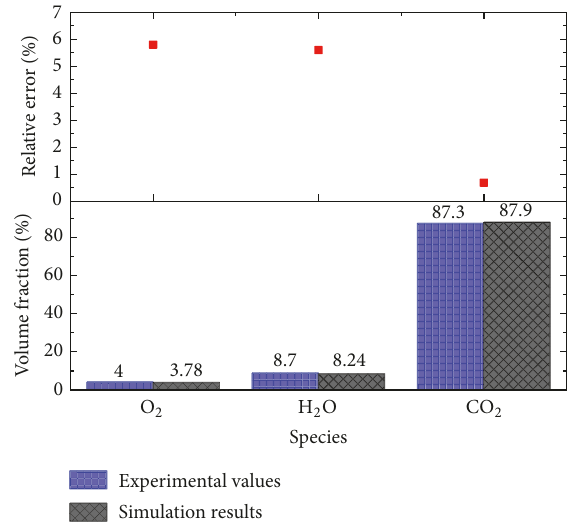
Figure 3: The experimental and simulation results of the outlet gas volume